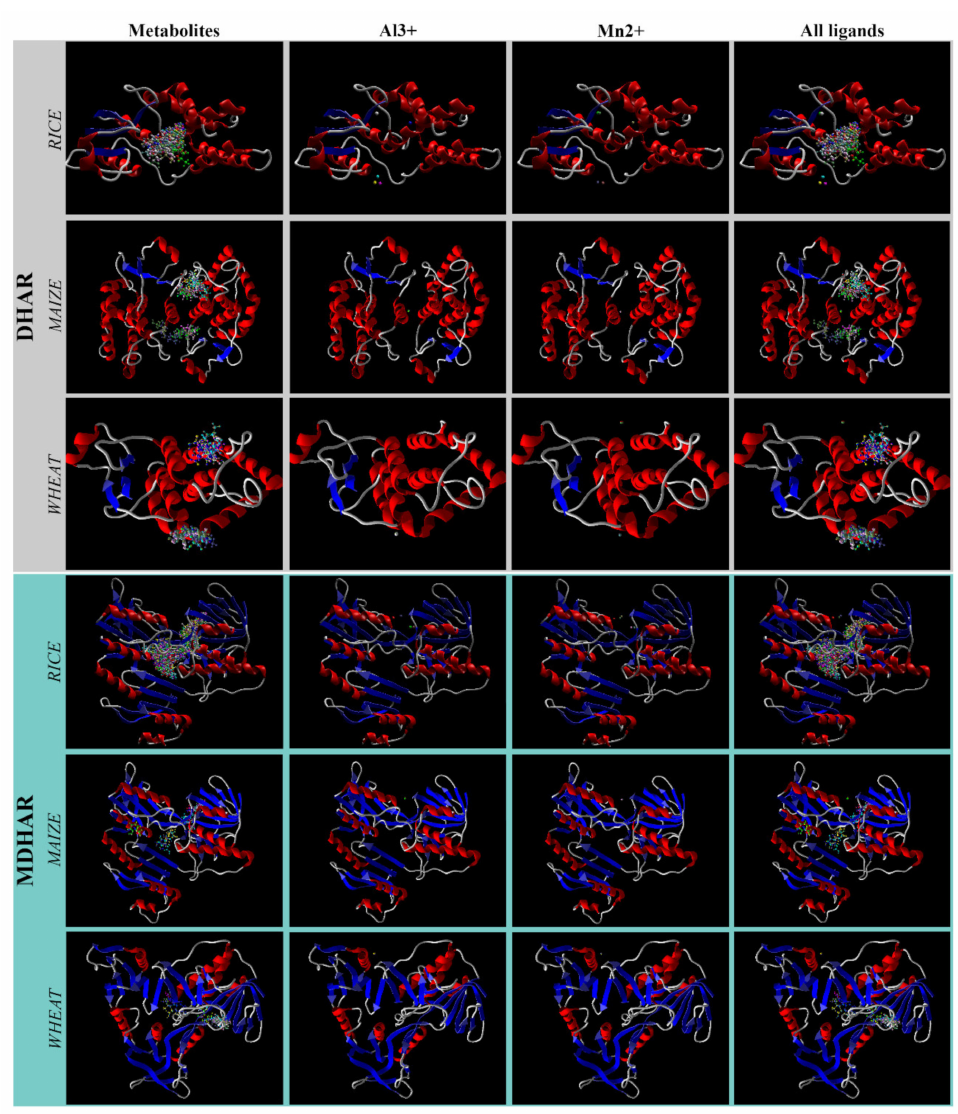
Figure 1. Docking poses of the metabolites and ions at the active sites of the six targets. The protein chain is shown in the secondary